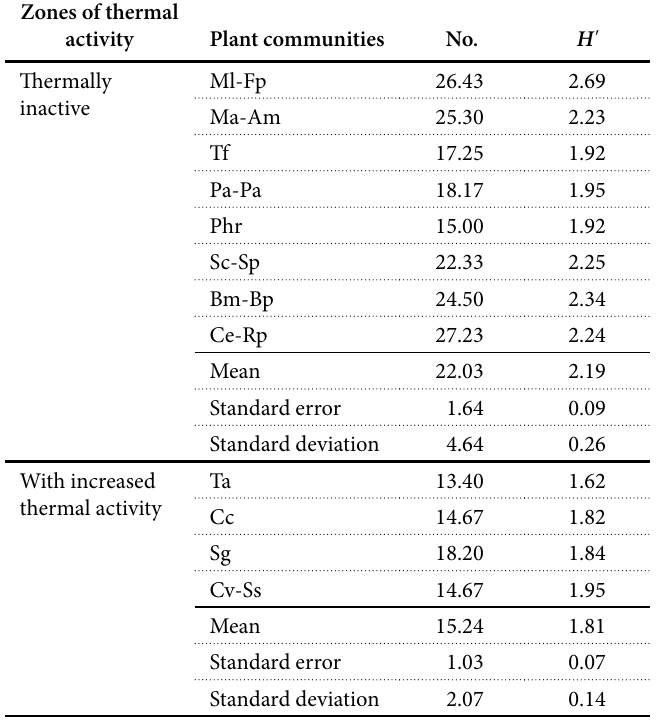
No. – the number of species that were recorded in the relevé; H' – the Shannon–Wiener diversity index. See the description of vegetation for explanations of the abbreviations of the names of the plant